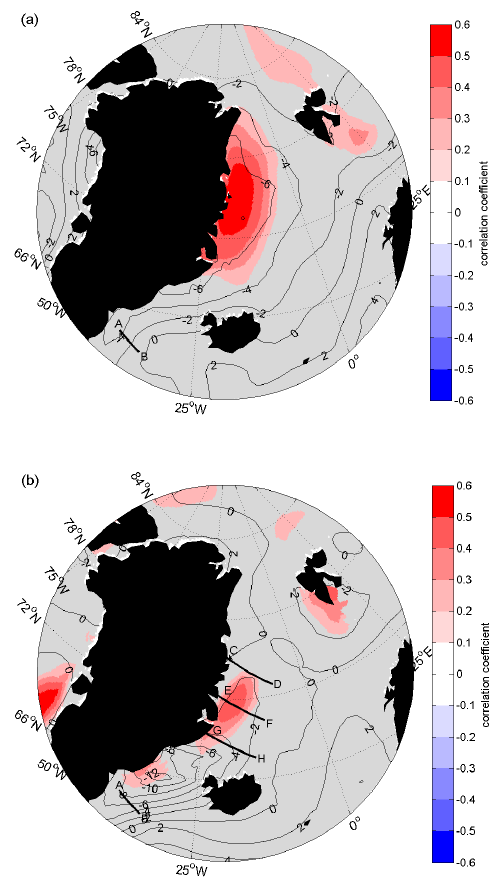
Fig. 11. Composite atmospheric sea level pressure anomalies (contours, in Pa) and meridional wind stress anomalies (coloured shading) for negative (a) and positive (b) wind stress anomalies at section CD (see Figure 10 for location). A negative anomaly denotes a stronger southward wind and a positive anomaly denotes a weaker southward wind.